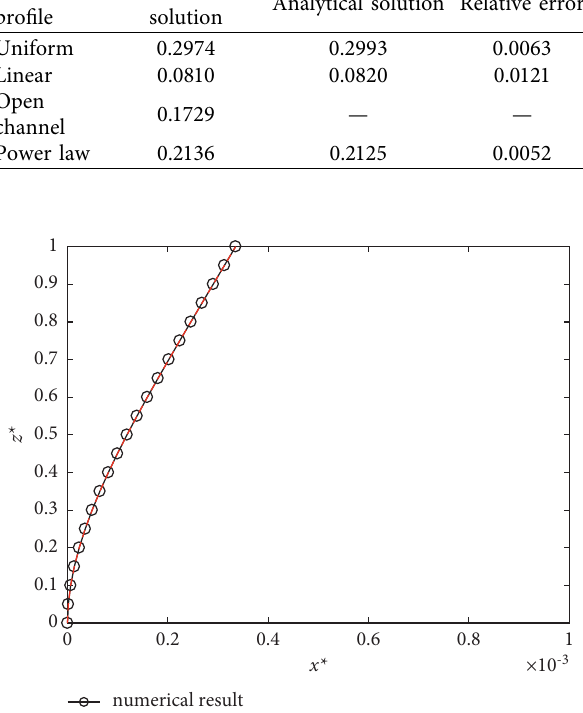
Figure 5: The deflection of the secondary core support pillar under the operating condition of the reactor, where the red dotted line represents equation